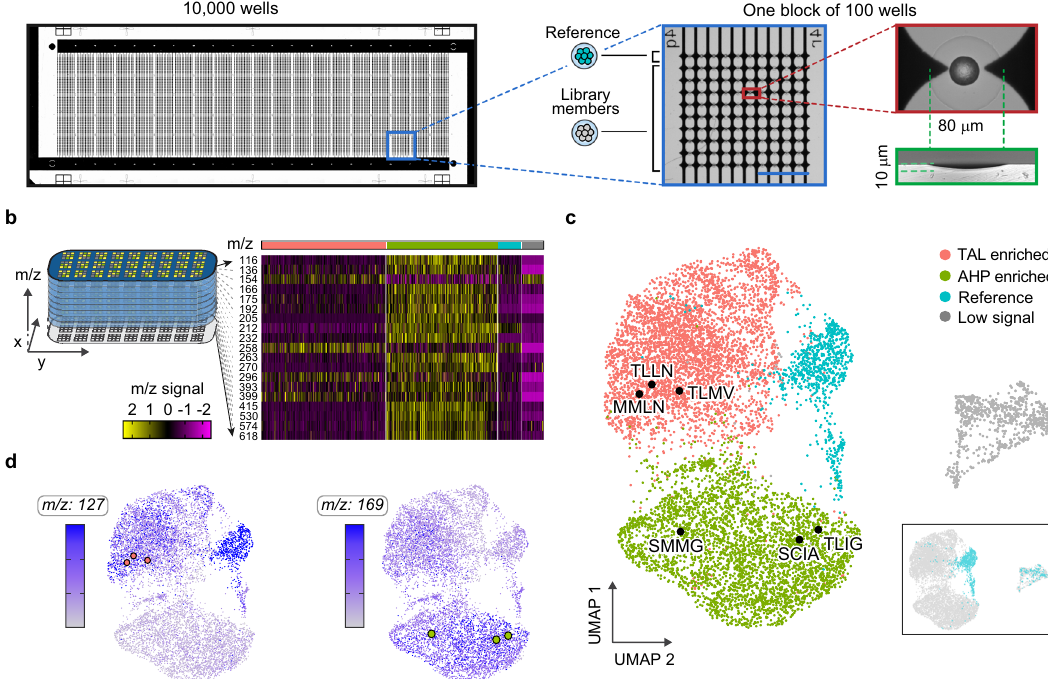
Fig. 3 Mapping g2ps1 mutant catalysis through metabolic biosensing. a Overview of the slide (75 mm × 25 mm) for single variant µ MS comprising 10,000 wells grouped in 100 blocks of 100 wells (magni fi ed blue box), scale bar 1 mm. Each circular well is paired with electrodes for printed droplet trapping (red box) and has a rounded pro fi le that concentrates desiccated metabolites to the center (green). b µ MS generates a spatial image of the substrate in which each pixel contains a full m / z spectrum. c Well spectra are extracted and clustered into four groups using UMAP. Mutants of interest are recovered, sequenced, and overlaid on the clusters as black dots. Inset shows the reference strain based on known print locations. d Heat maps for m / z 127 and 189 indicate high production of TAL in the upper and reference clusters, and high production of AHP in the lower cluster. Source data are provided in Supplementary Data that were misprinted (Supplementary Fig. 11). This leaves two peaks for inclusion, comprising ~60% of the total m / z intensity large clusters (red and green) that, presumably, correspond to (Fig. 3b, Supplementary Figs. 9 and 10, and Supplementary cells with distinct metabolomic pro fi les. Since only the embedded Movies 1 and 2) (see “ Methods ” ). From this, we observe four enzyme varies between these cells, this implies the codon-shuf fl ed clusters (Fig. 3c) that, visually, resemble UMAP clusters of single- library exhibits two major activities that perturb cell metabolism cell RNA-sequencing pro fi les, except that they correspond to in distinct ways. Mapping the m / z 127 data onto the clusters metabolite pro fi les 7,16 . The compact blue cluster is the 1000 control reference strains, which we con fi rm by substrate location shows that the upper red island represents productive TAL (Fig. 3c, inset). The gray island corresponds to wells with few cells mutants (Fig. 3d, left UMAP). In addition to the desired product,